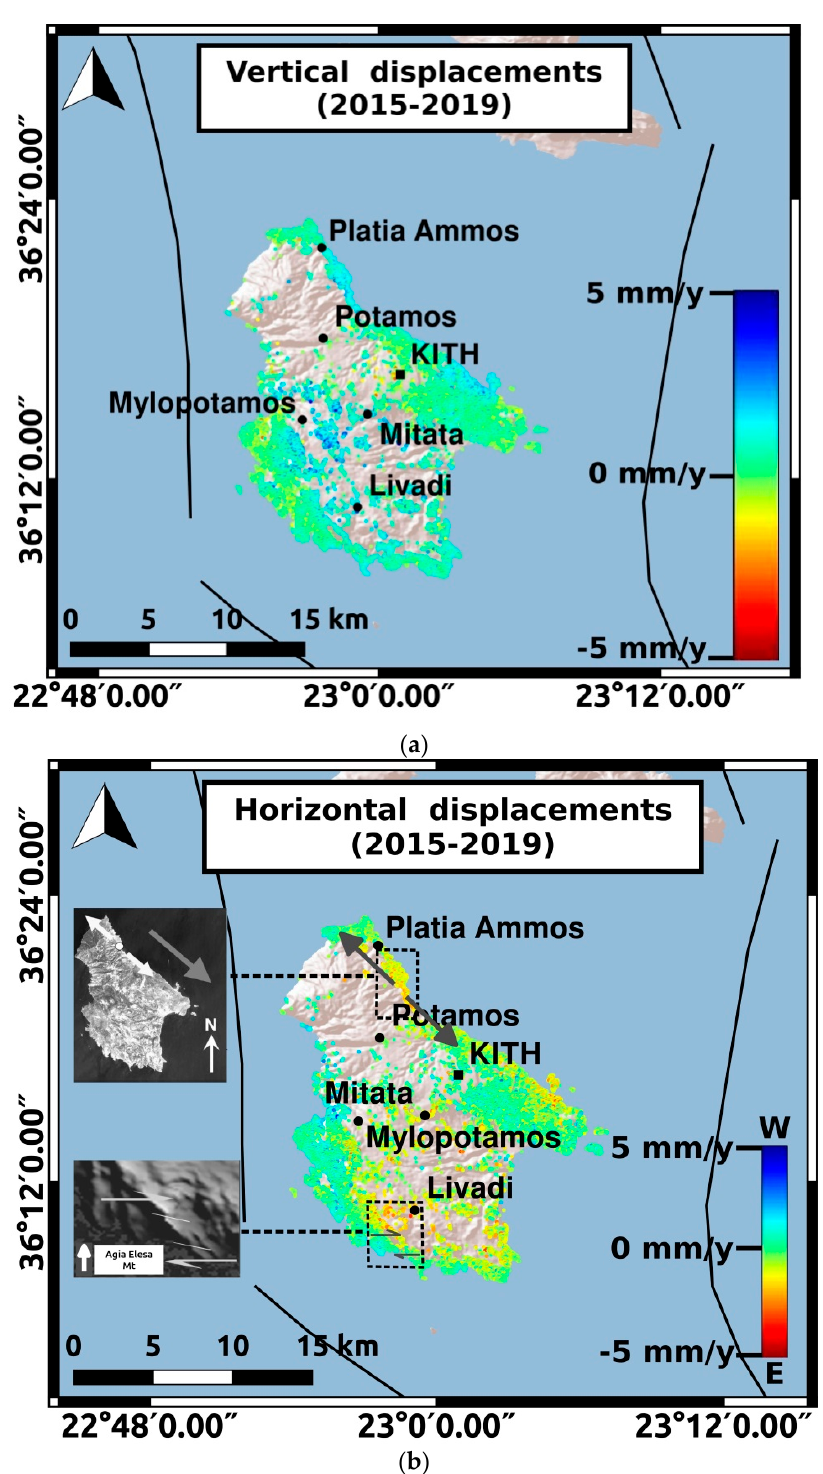
Figure 9. ( a ) Vertical displacements for the 2015–2019 period; ( b ) Horizontal displacements for the 2015–2019 period. KITH station and the settlements located near the regions where deformation occurs are also added. The inset images (Modified by [40]) depict the location and the direction of the detected extension, as well as dextral slip faults to the west of the Livadi village. The rectangles indicate the two distinctive areas where horizontal deformation occurs.